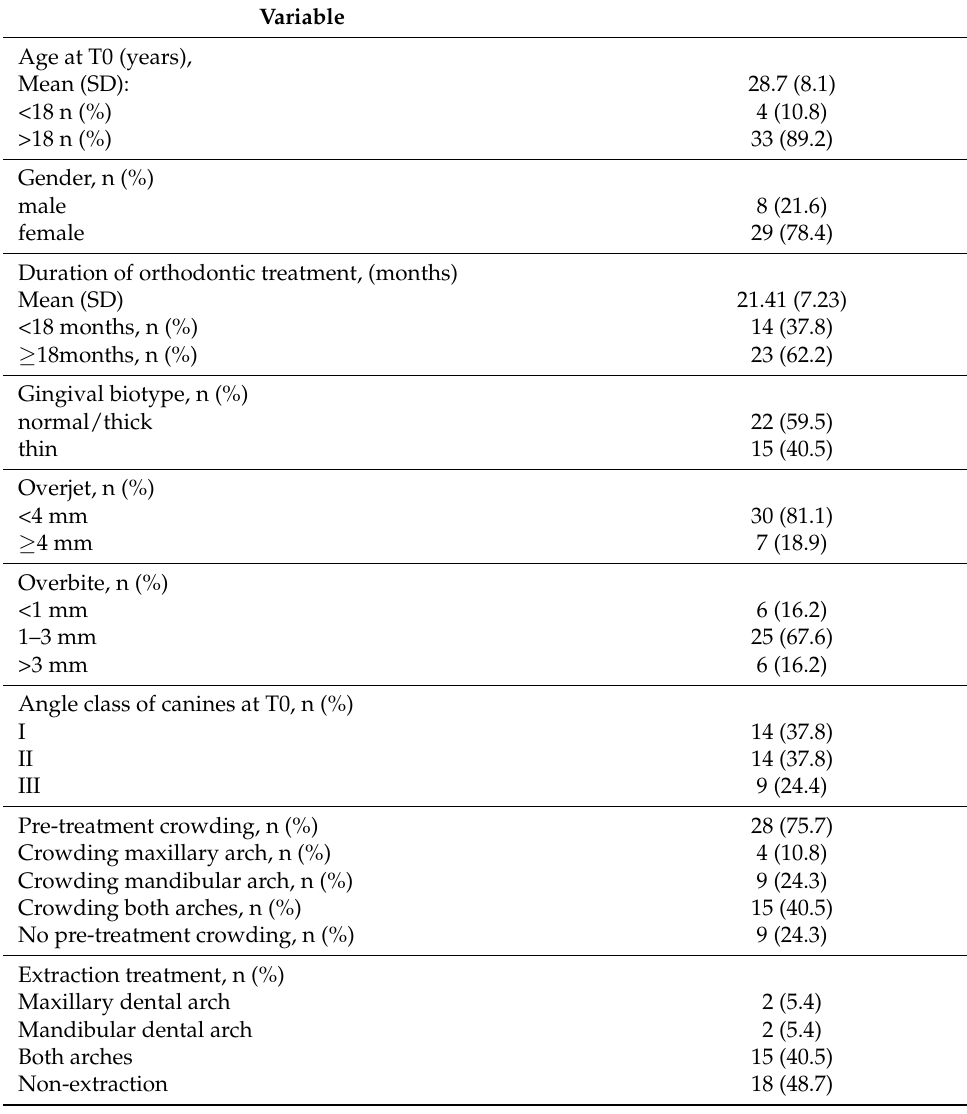
Table 1. Characteristics of included patients at